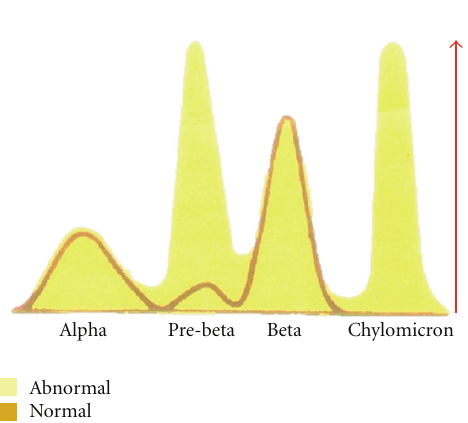
Figure 2: Lipoprotein electrophoresis showed predominant chy- lomicrons